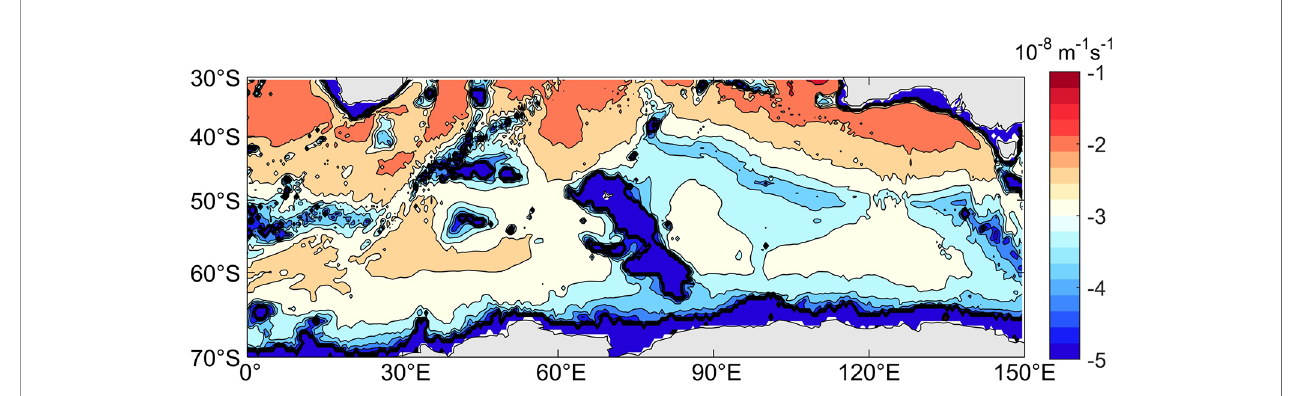
FIGURE 11 | Absolute value of planetary potential vorticity in the Southern Indian Ocean.